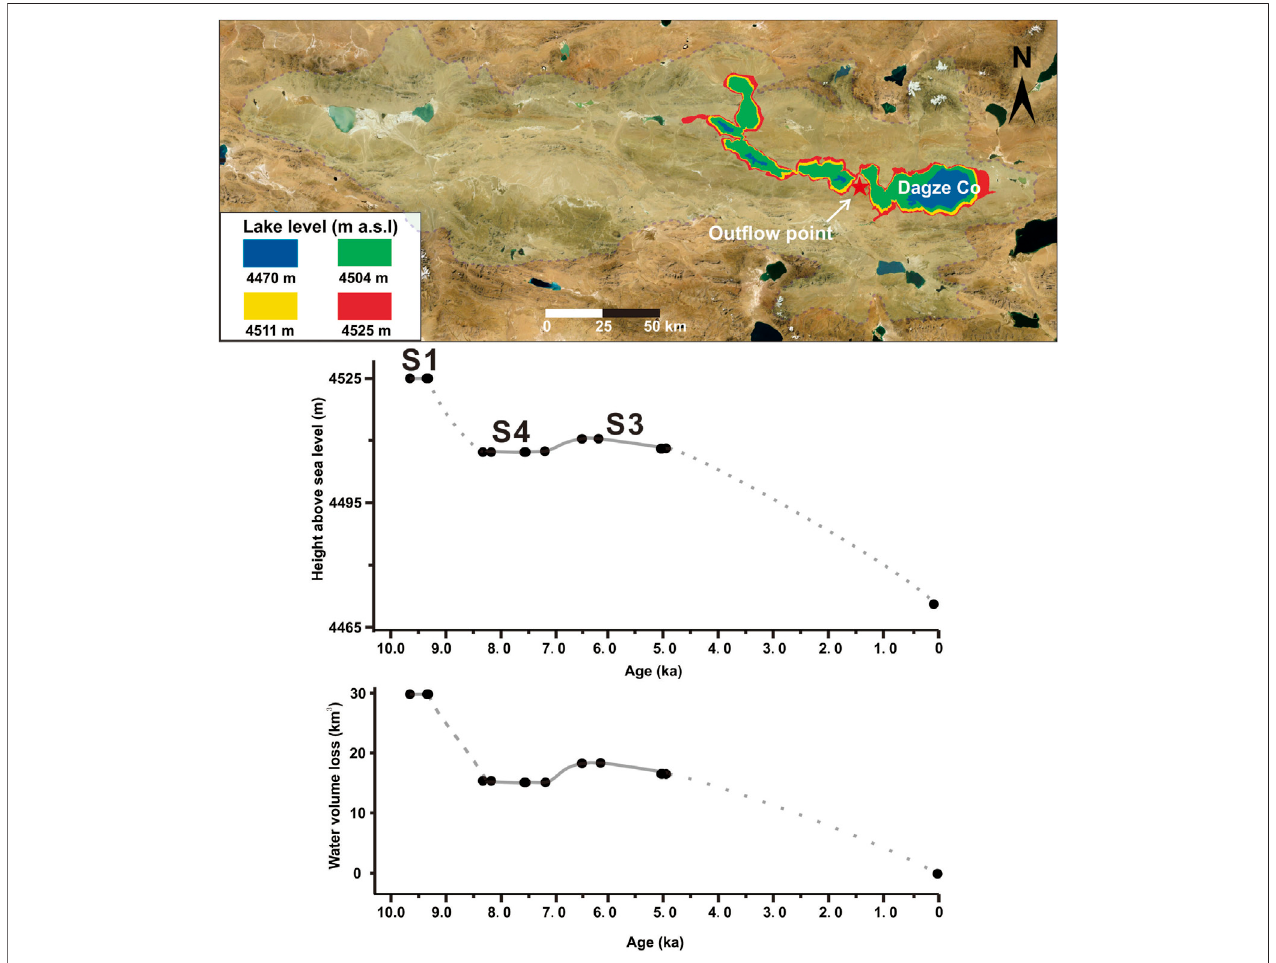
FIGURE 4 | Reconstruction of coverage areas for paleo-Dagze Co, and lake level fl uctuation history and water volume loss of Dagze Co since the early Holocene.